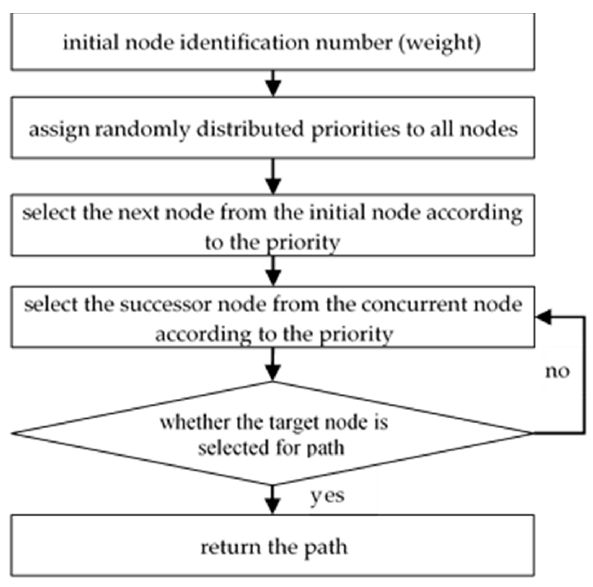
Figure 4. Indirect coding flow.